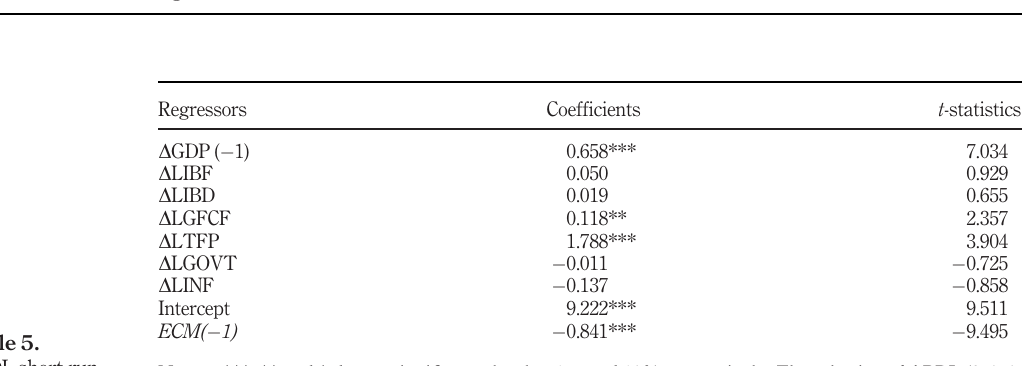
Table 4. Diagnostic tests